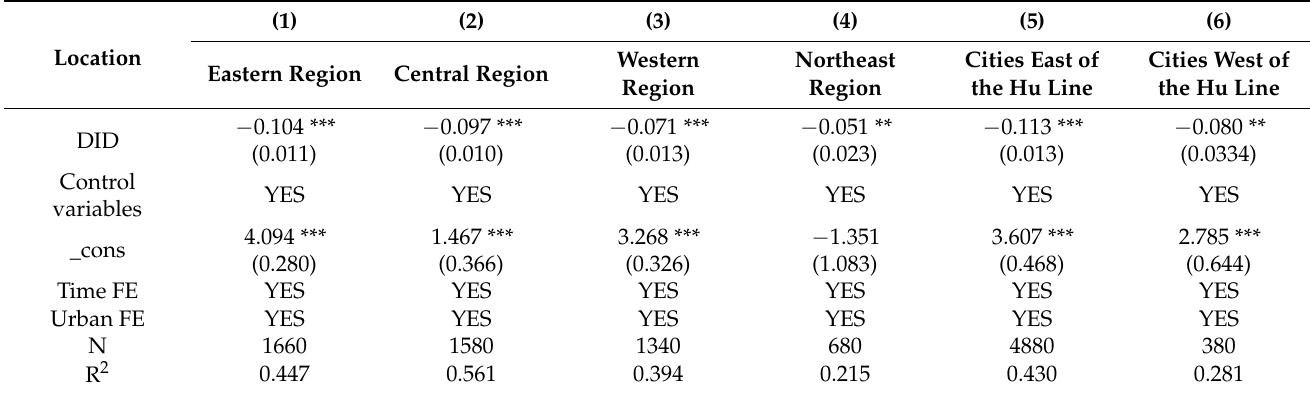
Table 5. Heterogeneity analysis of urban geo-economic